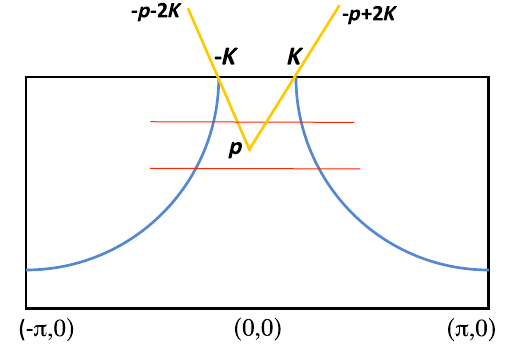
FIG. 1. Schematic representation of the top half of the cuprate Brillouin zone and the Fermi surface. Pairs are formed between fermions near K with momenta p and − p þ 2 K and similarly near − K . The Cooper pairs carry momenta Q ¼ 2 K and − 2 K , respectively. Red lines mark some of the scans shown in Fig.